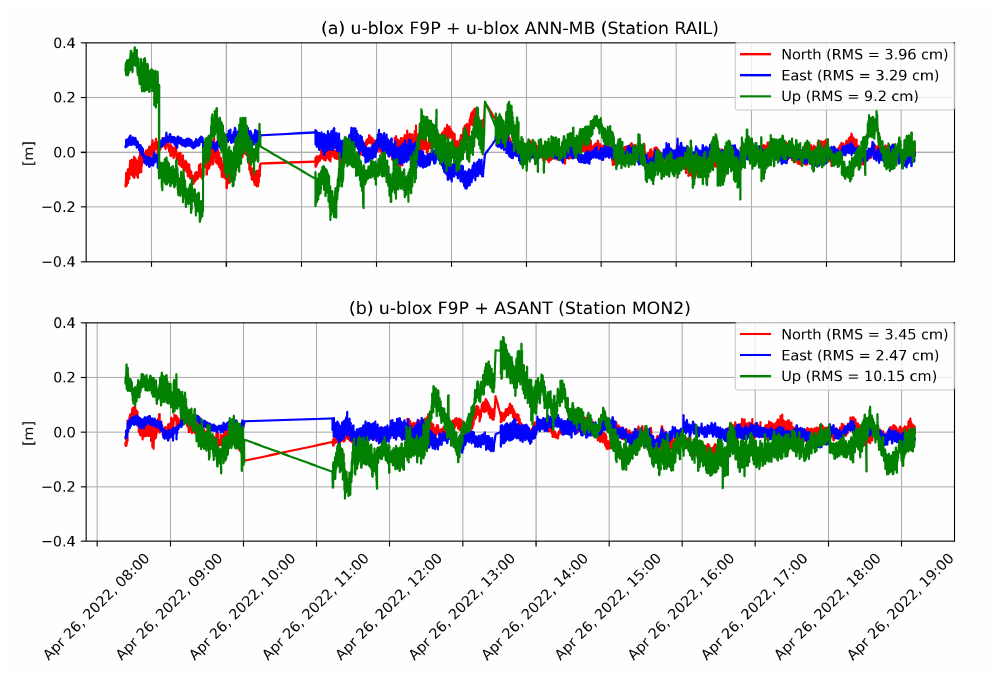
Figure 16. Session 3—sub-session 2: results for the kinematic displacements obtained from the static experiments—PPP-RTK solution obtained with PointPerfect.